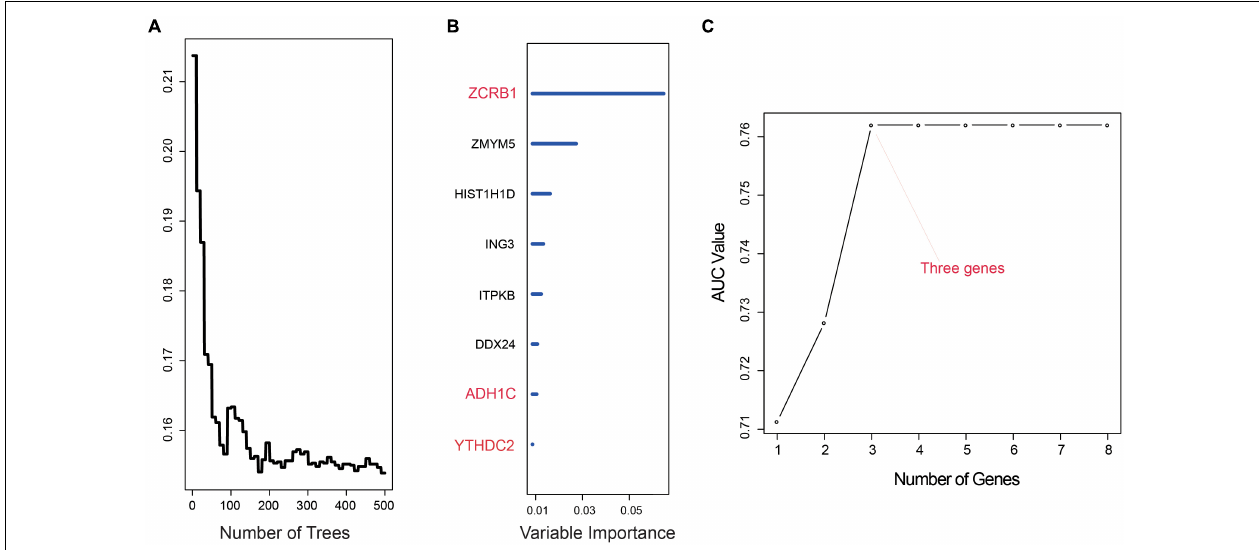
FIGURE 1 | Random survival forest analysis. (A,B) random survival forests variable hunting analysis reveals the error rate for the data as a function of trees and uses the associated score to filter N6-methyladenosine (m 6 A) RNA methylation regulators and m 6 A-related genes. (C) Receiver operating characteristic (ROC) for selected prognostic signature from all 255 signatures.